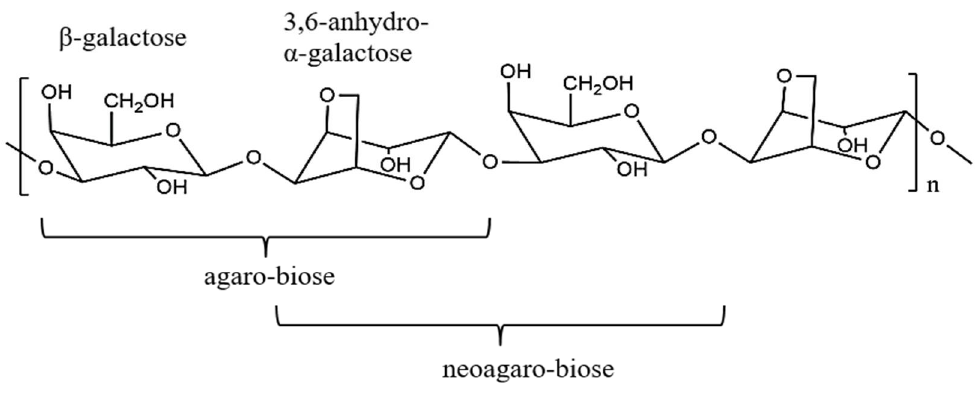
Figure 1. Schematic structure of agaro-oligosaccharides (AOS) and neoagaro-oligosaccharides (NAOS).